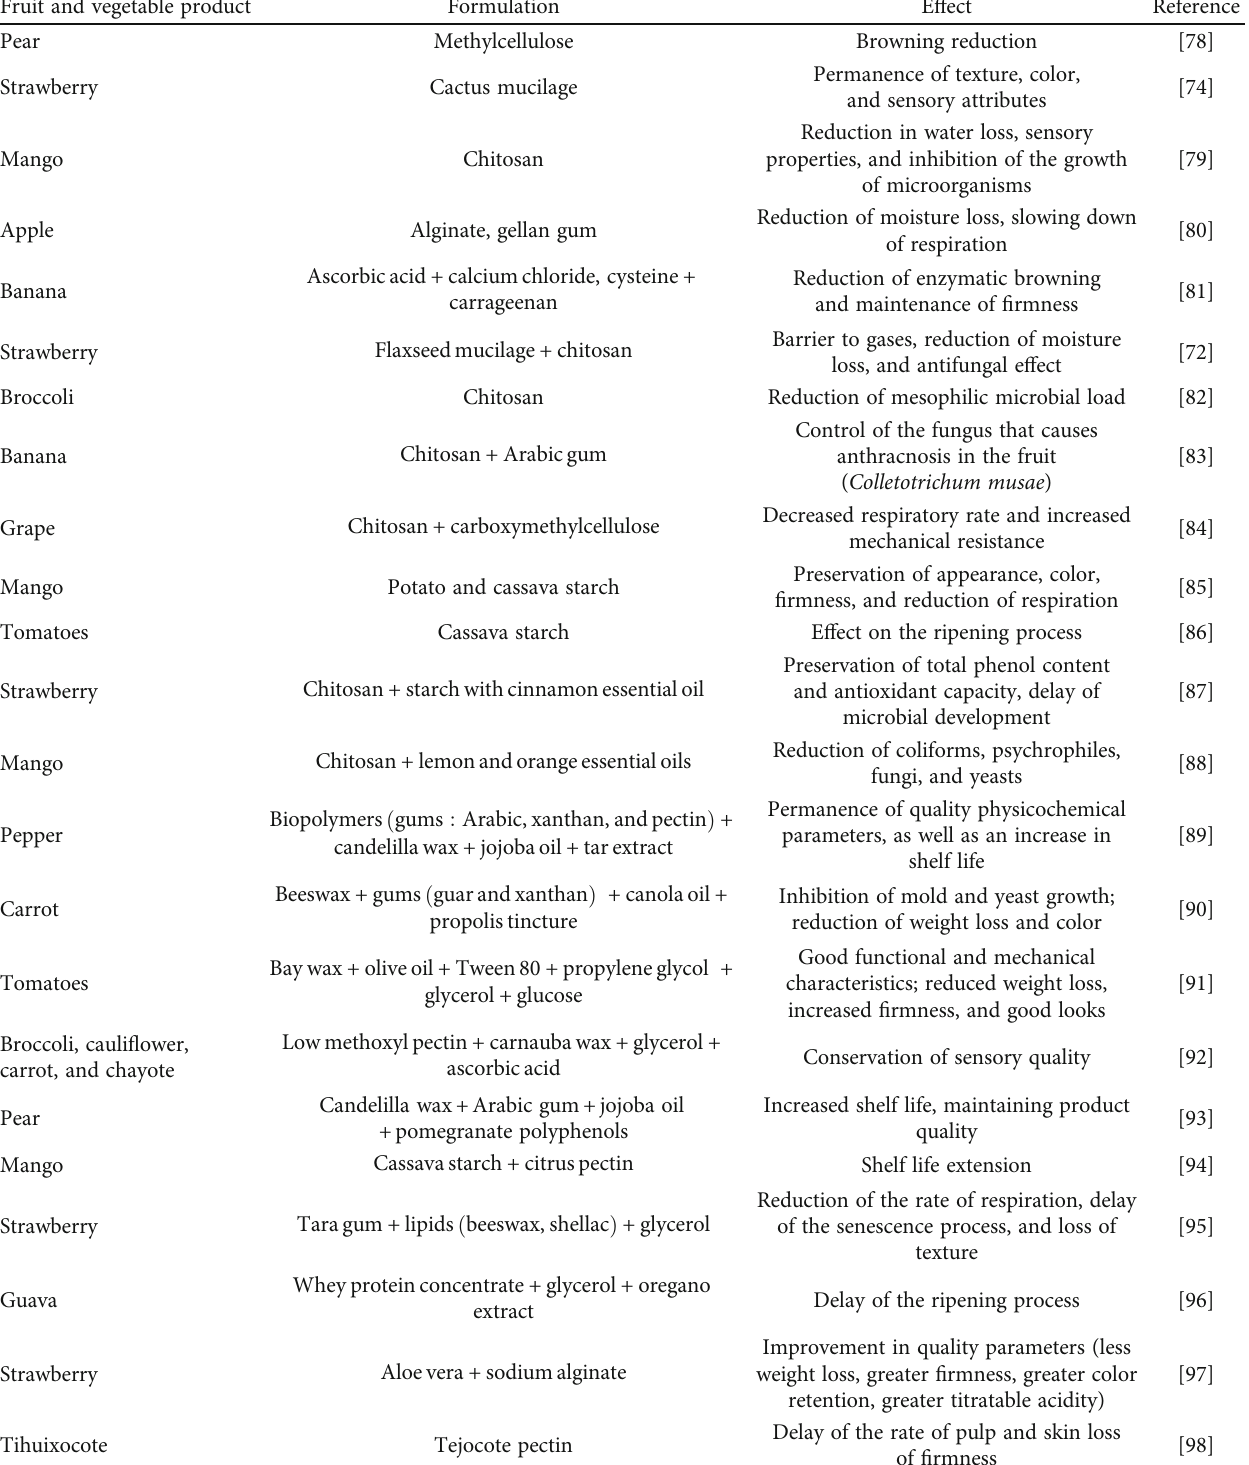
Table 3: Edible coatings and/or edible fi lms that are applied to fruits and vegetables to prolong their postharvest quality. Fruit and vegetable